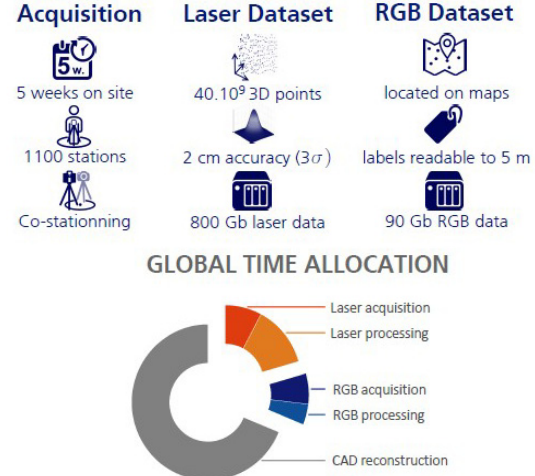
Figure 2 : Key numbers of the multi-sensor scanning survey of a nuclear reactor building; the main order of magnitude that may be highlighted is number of stations: more than 1000 stations (for more details see [Hullo and Thibault, 2014]).